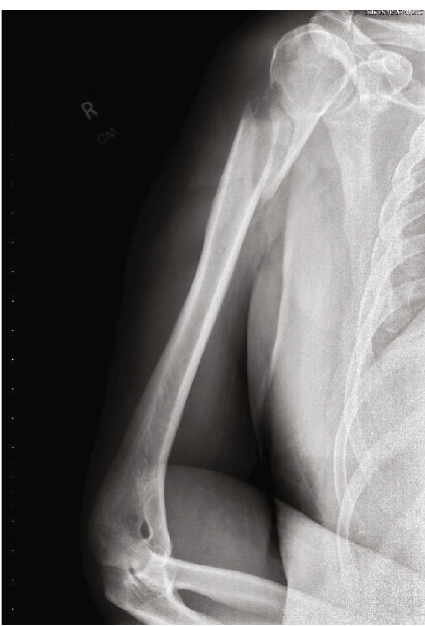
Figure 1: X-ray of the shoulder showing spiral fracture of proximal diaphysis of the humerus with displacement and angulation of the distal fractured